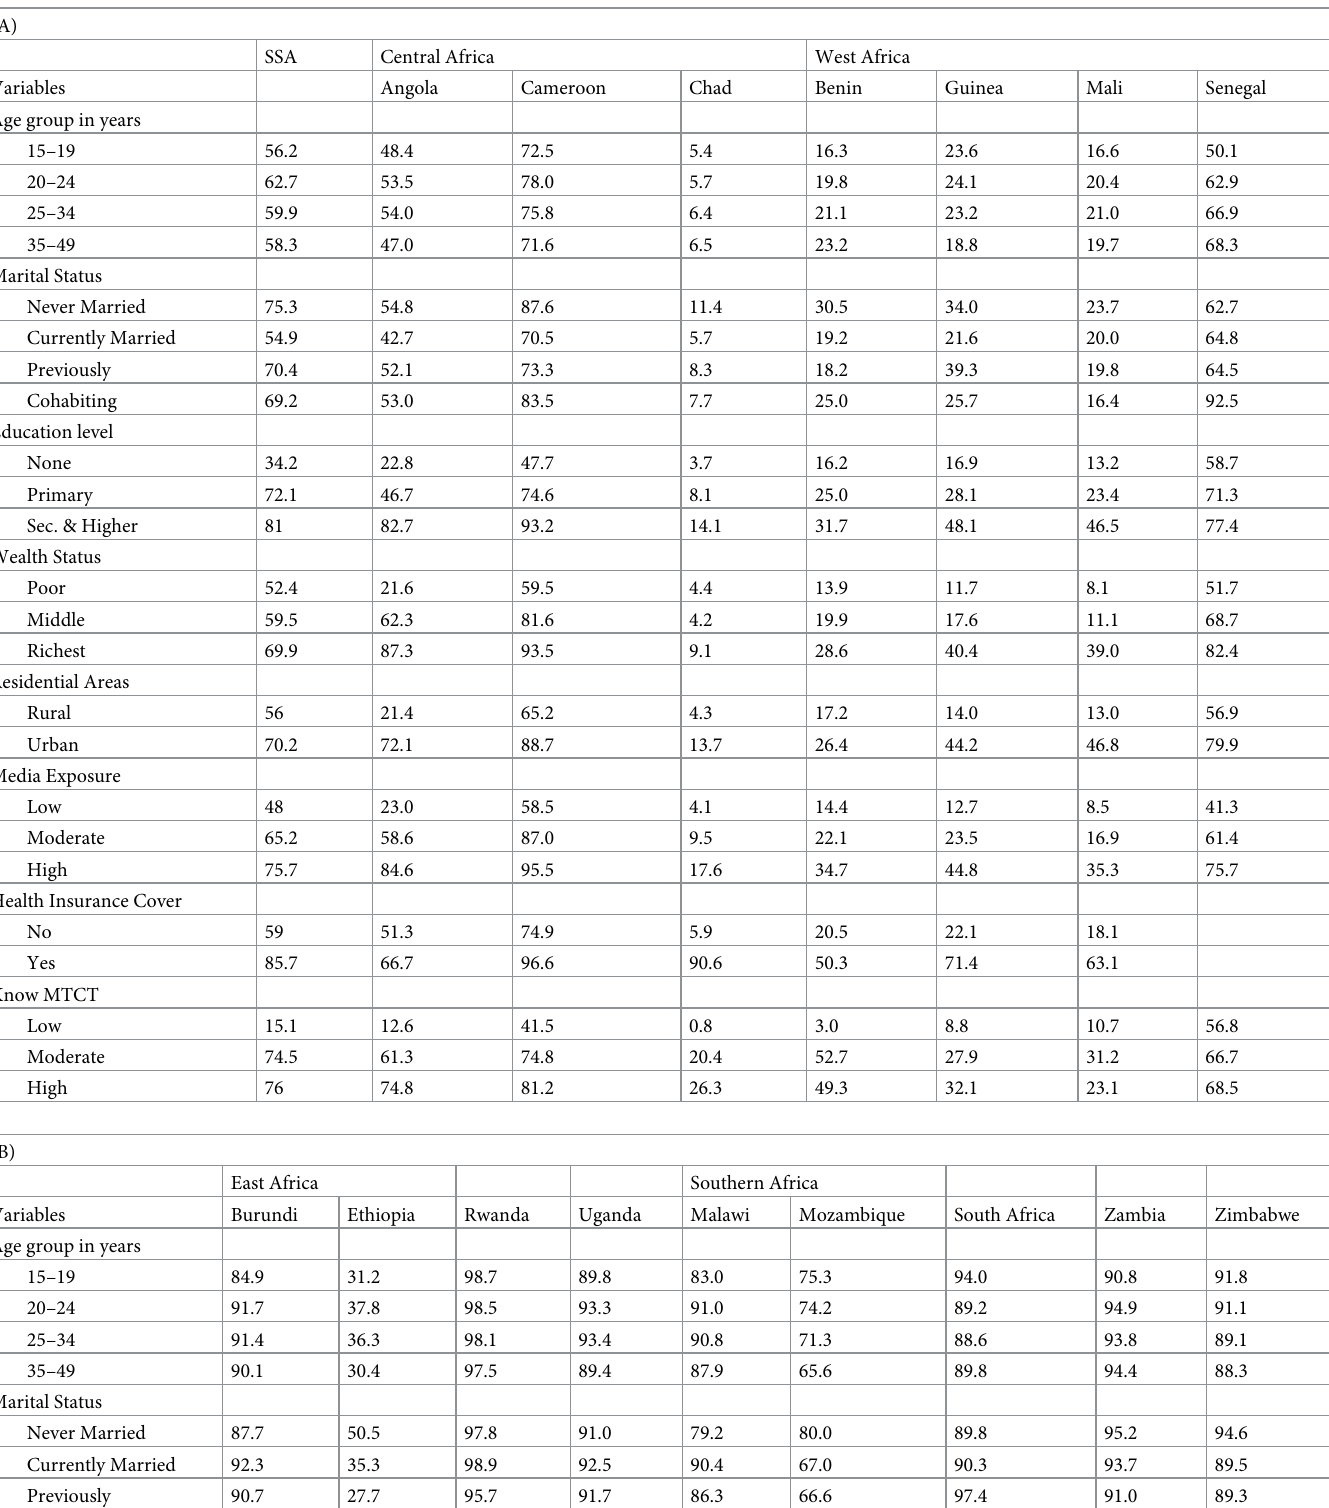
Table 2. Relationship between background factors and prenatal care uptake of HIV testing stratified by country. (A) SSA Central Africa West Africa Variables Angola Cameroon Chad Benin Guinea Mali Senegal